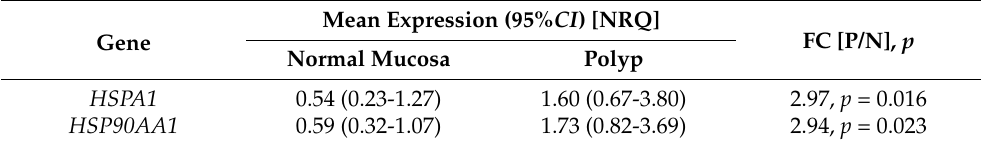
Table 3. Heat shock protein HSPA1 and HSP90AA1 expression in patients with colorectal polyps.